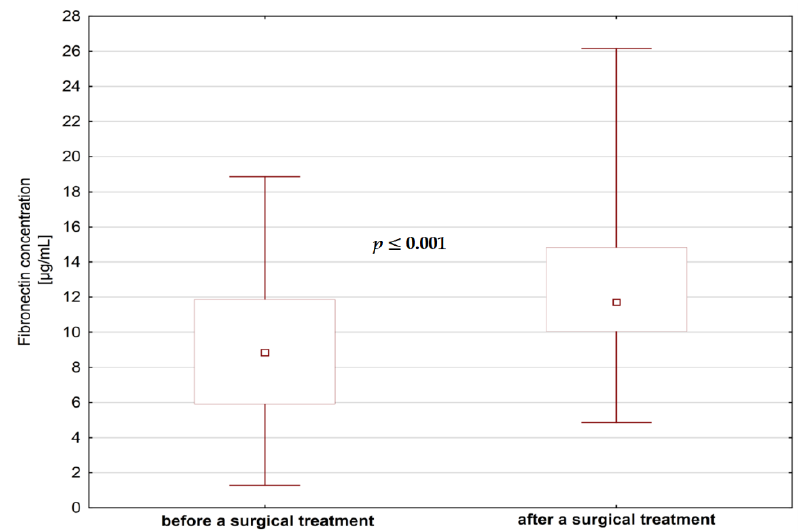
Figure 6. The concentrations of fibronectin in saliva before and after surgical treatment.